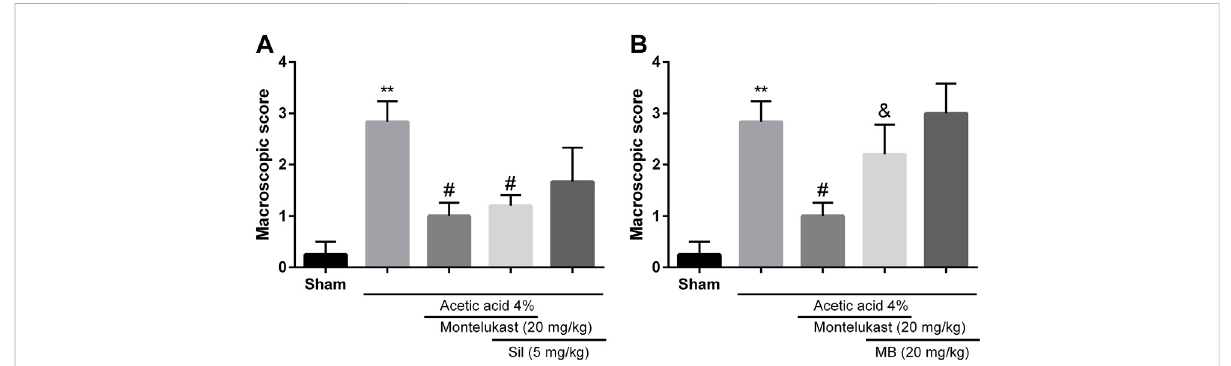
FIGURE 3 Evaluation of the involvement of the cGMP in the protective effect of montelukast (Mon, 20 mg/kg) on the macroscopic score of colon tissue. Theeffectofpre-treatmentwithsildena fi l(Sil,5 mg/kg,(I)p.)andMethyleneblue(MB,20 mg/kg,(I)p.)ontheeffectofMonisshowninpanels (A) and (B) , respectively. The results are expressed as the means ± SEM of six rats per group. **p < 0.01, when compared to theSham group; # p < 0.05 when compared to the acetic acid group; & p < 0.05, when compared to the Mon-treated group. The statistical analysis was performed by ANOVA followed by Tukey ’ s post hoc